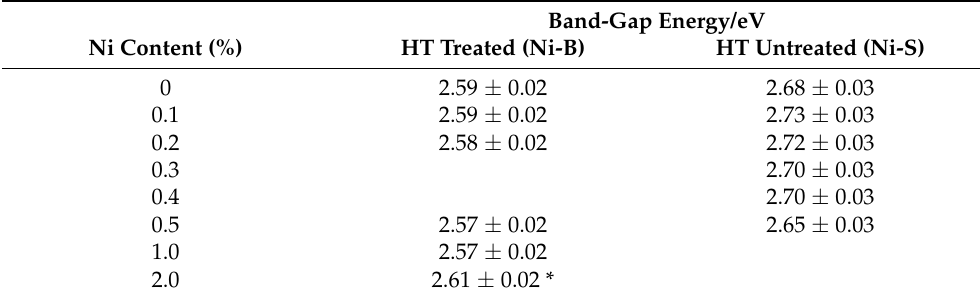
Table 1. The band-gap energies of different catalysts (precipitated from solution of ammonia in 2-fold excess) determined from Tauc-representation [52] of KM-functions (Figure S4 in the Supplementary Materials). The “Ni-B” and “Ni-S” designations (in parentheses) represent the bulk and the surface modifications,